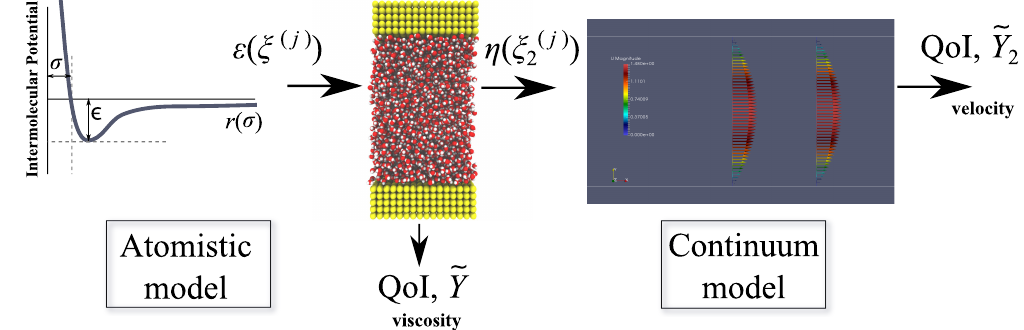
Figure 2. Workflow for uncertainty quantification in multi-scale simulation. QoI: quantity of